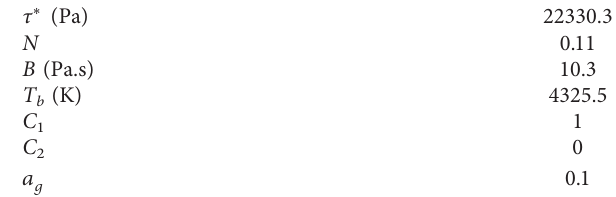
Figure 1: Schematic of the RICM process. Table 1: Parameters of the reactive viscosity model for the NBR60 compound.